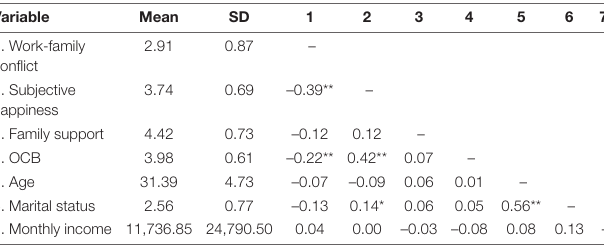
TABLE 1 | Descriptive statistics and correlations between the variables. TABLE 2 | Results of the moderated regression analyses.